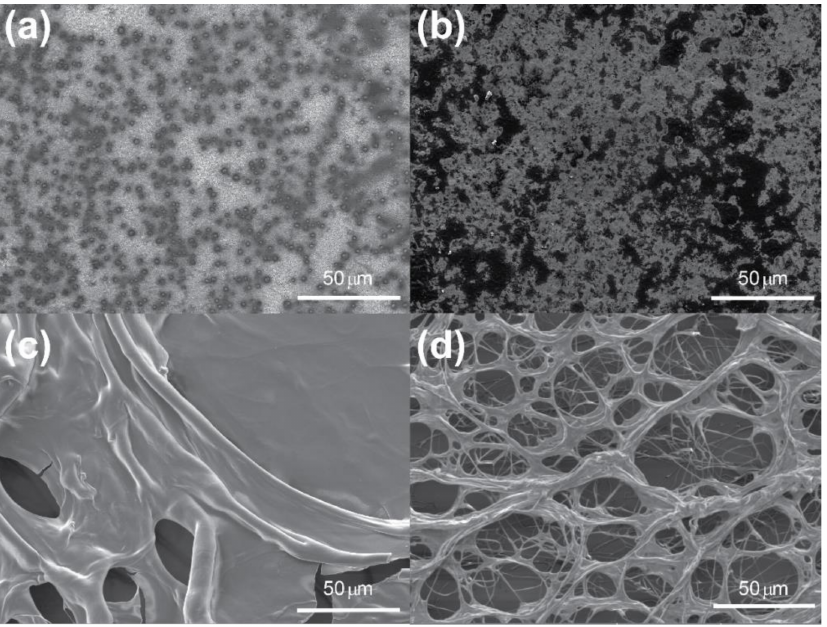
Figure 7. Scanning electron micrographs of air-dried chitosan ( a ) and alginate ( b ) and freeze-dried chitosan ( c ) and alginate ( d ) in the presence of wood extractives, magnification 1.38 k ×